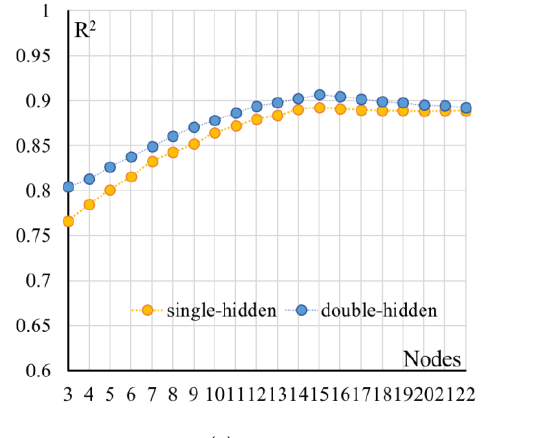
Figure 3. Comparison chart of the accuracy for different structures. ( a ) Comparison chart of R 2 between single-hidden and double-hidden layers with nodes (from 3 to 22); ( b ) Comparison chart of RMSE between single-hidden and double-hidden layers with nodes (from 3 to 22).